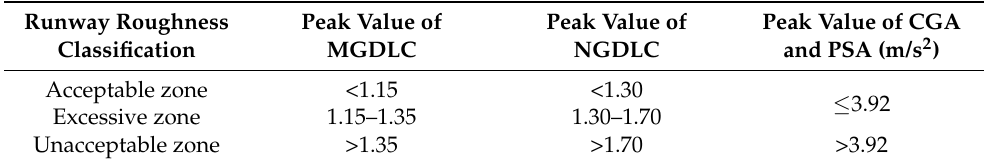
Table 6. Aircraft dynamic response control criteria that correspond to Boeing Bump evaluation standard.